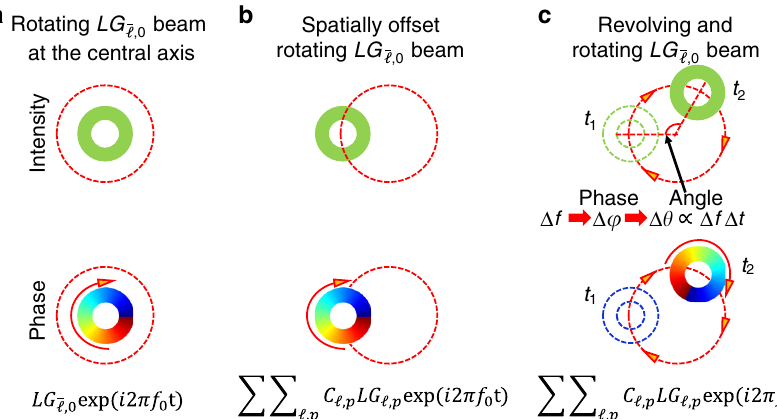
Fig. 2 Coherent interference of multiple frequency comb lines leading to the dynamic rotation and revolution. a LG (cid:1) ‘; 0 beam on a single frequency whose center located at the central axis. b The interferogram of multiple LG ‘; p modes with multiple ‘ values and p values carried by a single frequency line. It produces an LG (cid:1) ‘; 0 beam whose beam center is offset from the original central axis. c Combining multiple frequency comb lines with each carrying a superposition of multiple LG ‘; p modes (a different ‘ value and multiple p values). Δ φ : time-variant relative phase delay between neighboring LG ‘; p modes, leading the generated light beam to dynamically revolve around the central axis; Δ f : frequency spacing; Δ θ : revolving angle; Δ t : t 1 – t 2 is the